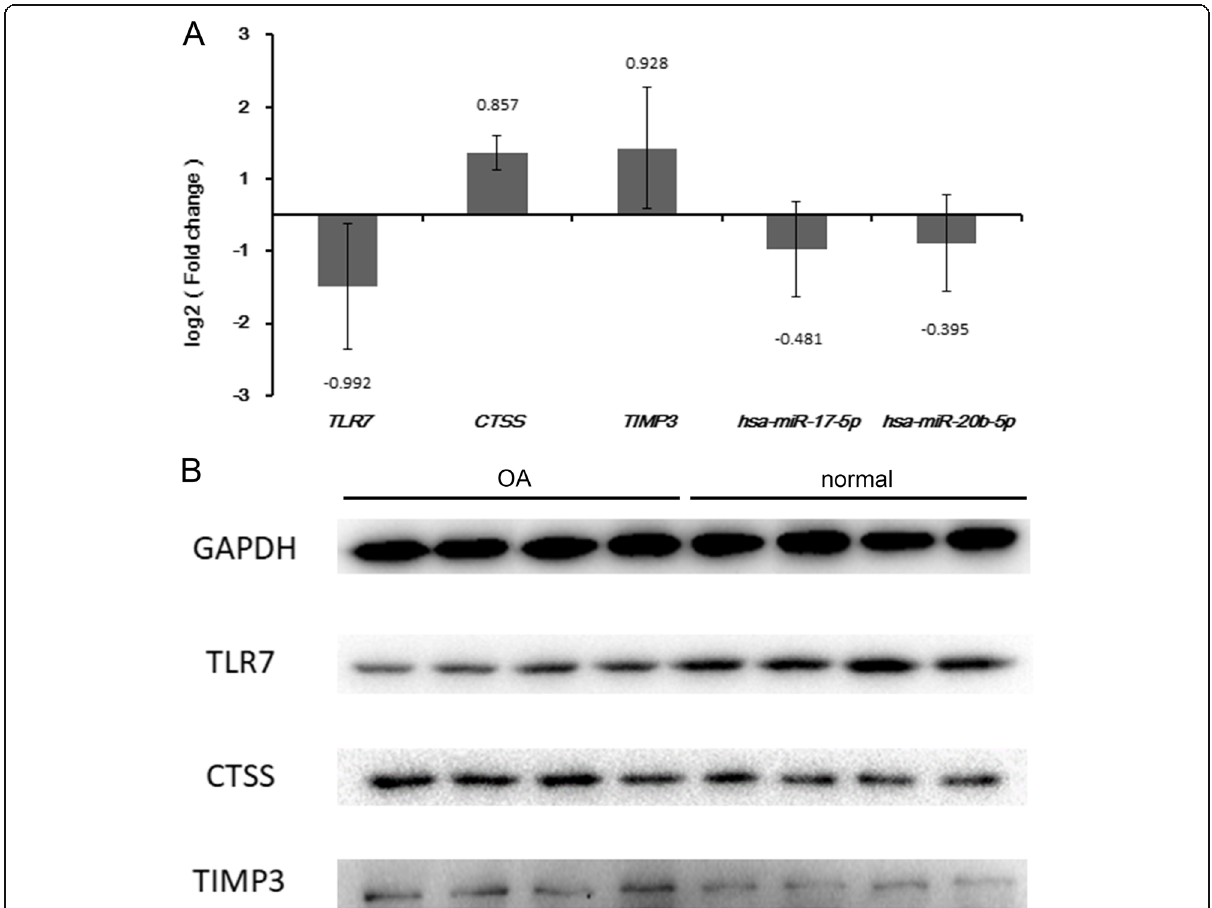
Fig. 6 The results of qRT-PCR and western blot. a . The quantitative real time polymerase chain reaction (qRT-PCR) results of the DEmRNAs and DEmiRNAs in OA. The x-axis represents the DEmRNAs/DEmiRNAs and the y-axis represents log 2 (fold change). b . Western blotting analysis of TLR7, CTSS and TIMP3 protein levels in OA and normal controls. GAPDH protein was used as the loading